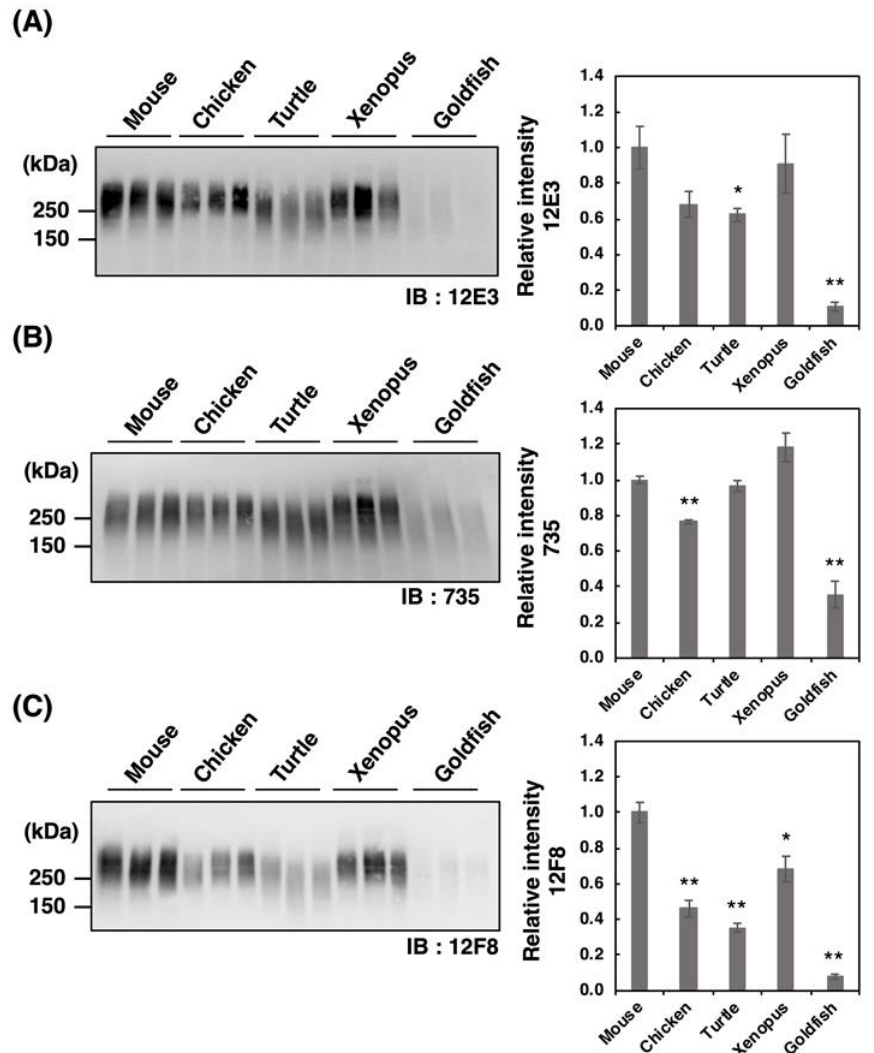
Figure 2. SDS–PAGE / Western blotting of polySia–NCAM derived from five vertebrate brains. Brains from five vertebrates (mouse, chicken, turtle, xenopus, goldfish, n = 3) were used. PolySia expression was analyzed using SDS-PAGE / Western blotting. The brain homogenates were separated by SDS-PAGE (7% polyacrylamide gel) and blotted onto polyvinylidene difluoride (PVDF) membrane (10 µ g as protein / lane). The polySia-NCAM was visualized using anti-polySia antibodies, ( A ) 12E3, ( B ) 735, and ( C ) 12F8. The left panel represents the immunoblots. The right panel shows the relative intensity of the anti-polySia antibody. Mouse staining was set to 1.0. * indicates p < 0.05. ** indicates p < 0.01.